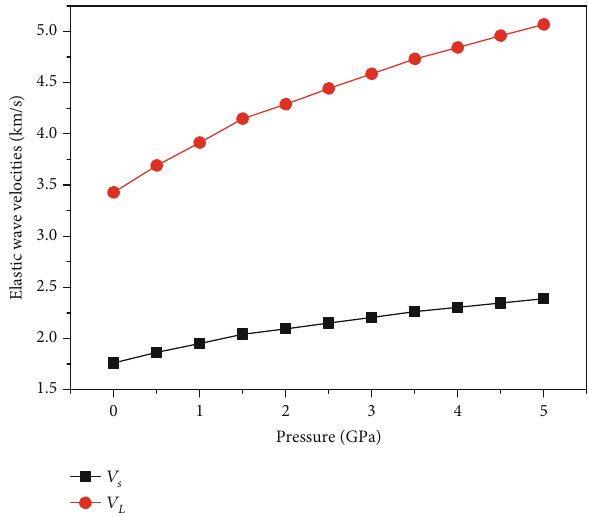
V S ) velocities of